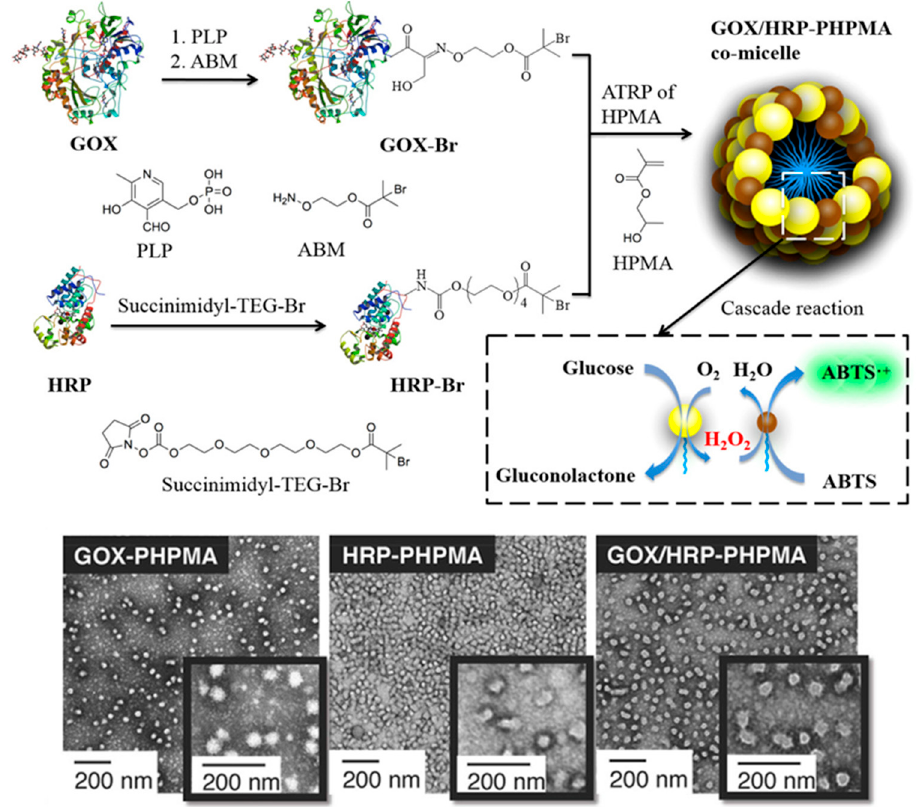
Figure 2. Synthesis of GOx/HRP- g -PHPMA hybrid co-micelles via aqueous ATRP-mediated PICA ( top ), and representative TEM images of developed GOx-, HRP-, and GOx/HRP-based spherical nanoparticles ( bottom ). Adapted with permission from reference [60]. Copyright 2019 American Chemical